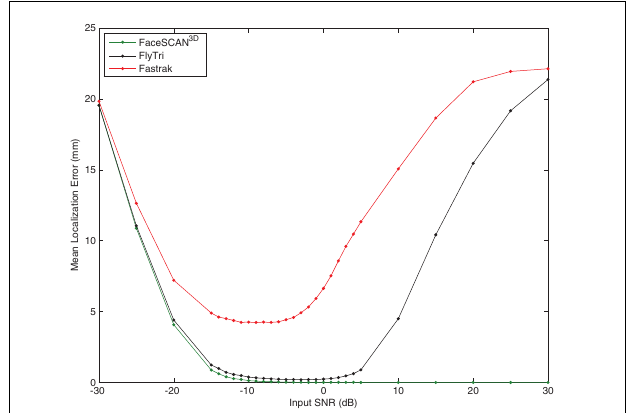
FIGURE 6 | The ultimate source localization error for each set of electrode coordinates was assessed at each input SNR. Shown here is the mean localization error across sources simulated at each location of the voxel grid. As with output SNR, the source localization performance with Fastrak and FlyTri coordinates improves but then deteriorates again with further increases of input SNR. However, the source localization with FlyTri coordinates approaches negligible error ( < 1mm) for a wide range of input SNRs, in contrast to the Fastrak